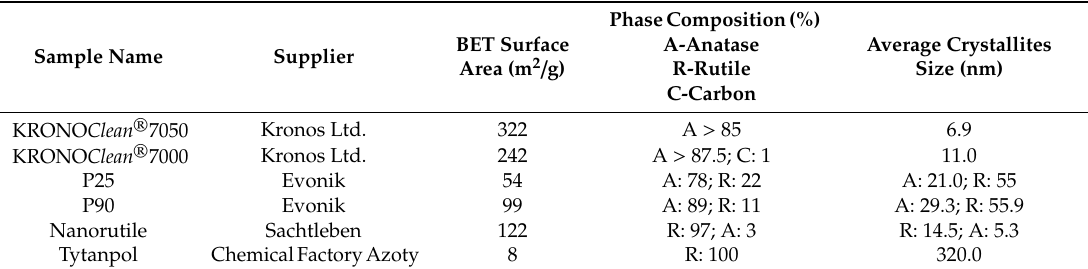
Table 2. Characteristics of commercial titanias.